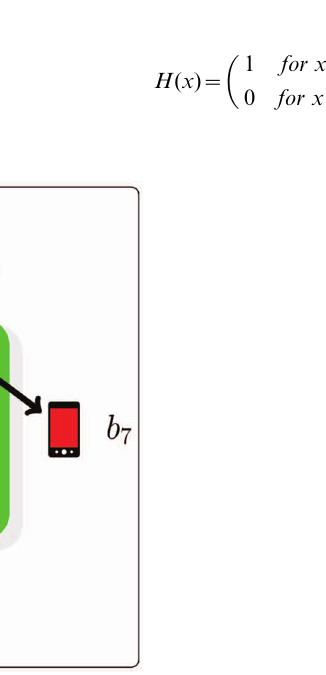
Figure 2. An example of the { situation. Starting from the initial configuration (7,2) , b 1 infects the clean mobile w 1 , b 2 pairs to b 3 , b 4 infects w 2 and, finally, b 5 pairs to b 7 . Here the process ends, because there are no more mobiles available for pairing to b 6 which remains unconnected. doi:10.1371/journal.pone.0059468.g002 PLOS ONE |